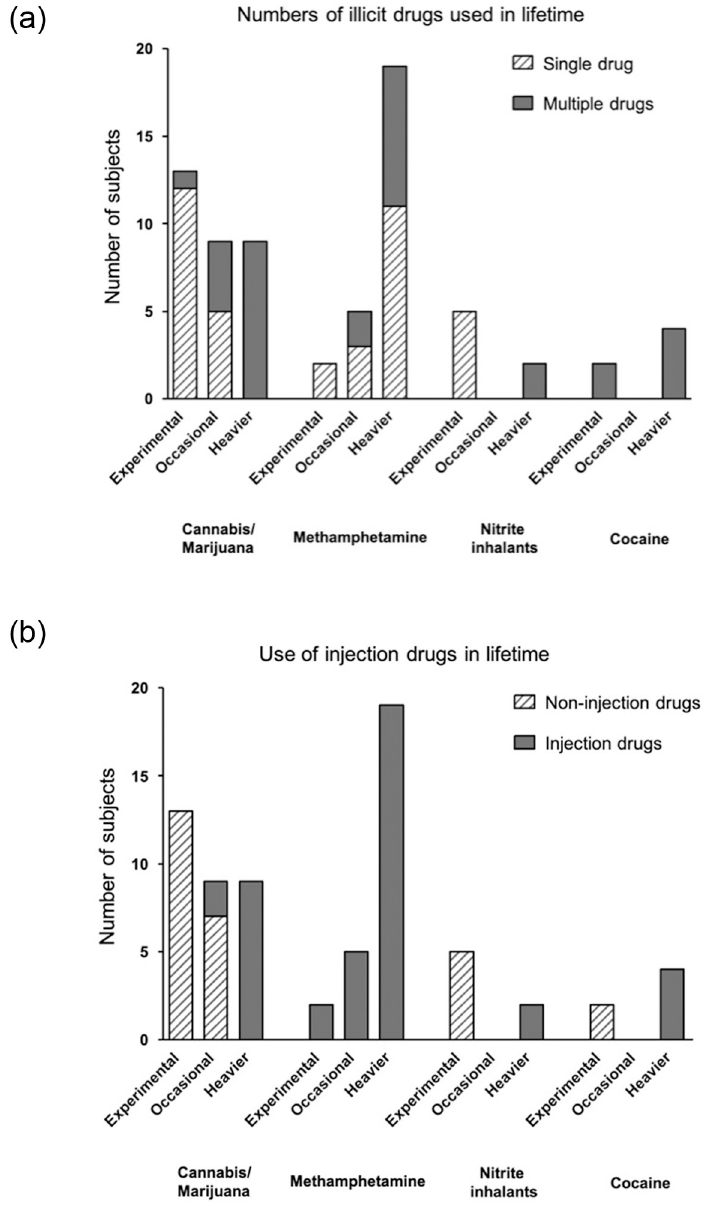
Fig 3. Life-time use patterns of four most frequently reported illicit drugs, categorized by drug consumption levels. A: Numbers of illicit drugs used in a lifetime, B: Use of injection drugs in a lifetime.